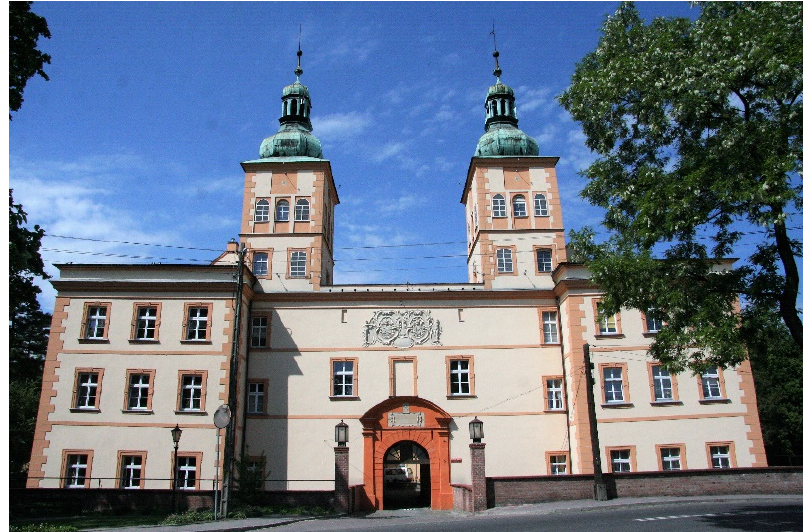
Figure 4. Prószków castle: east elevation; photo by the authors . Figure 4. Pr ó szk ó w castle: east elevation; photo by the authors.